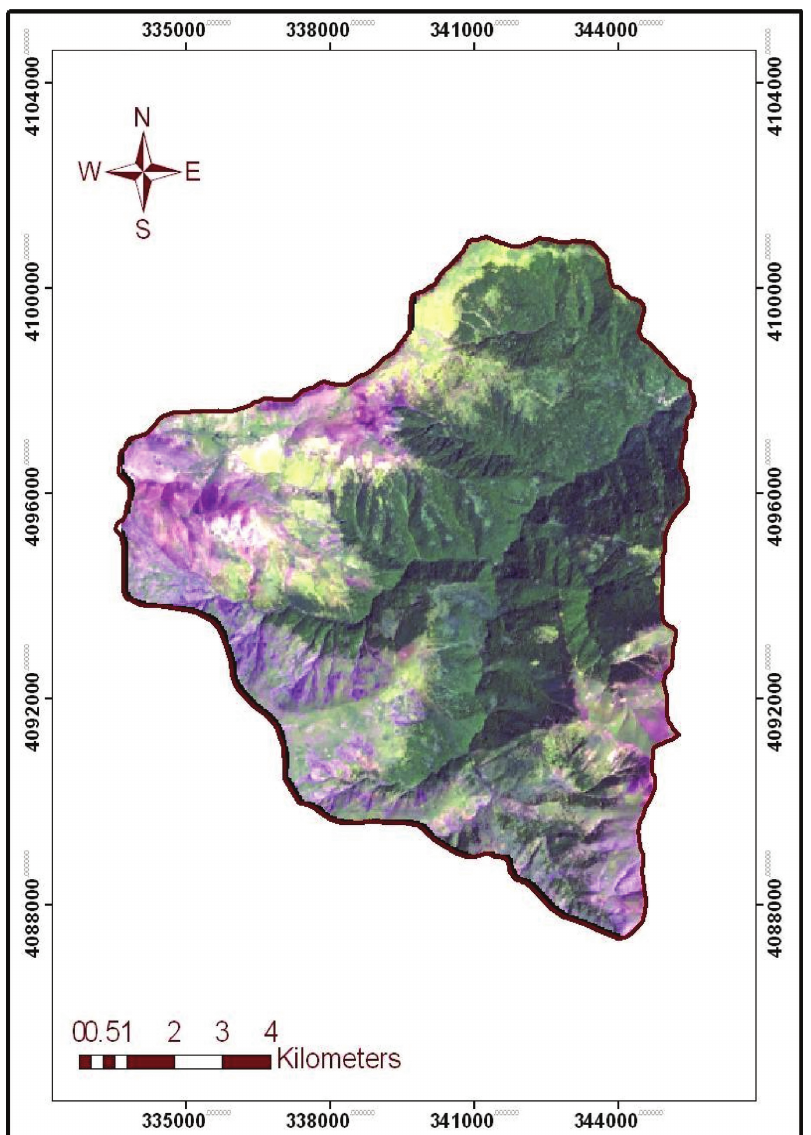
Figure 1 - Band combination 3, 6, 7 in the image of